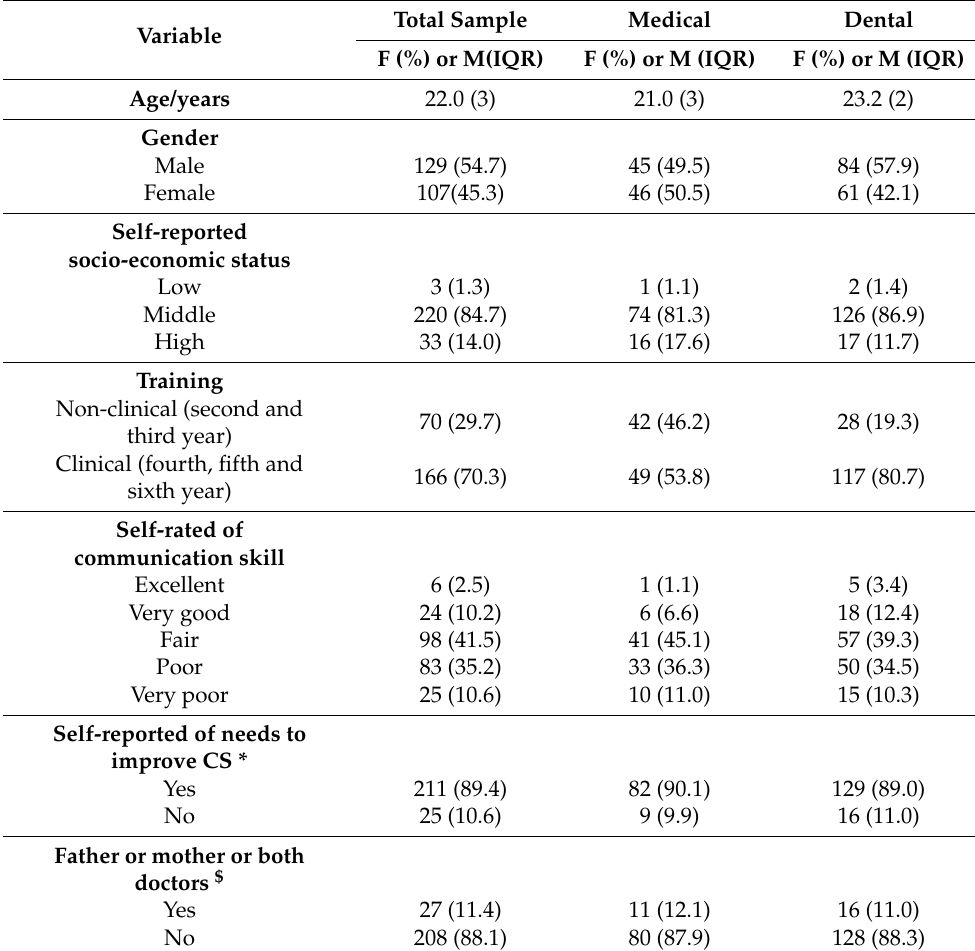
Table 1. Whole sample sociodemographic and education-related characteristics of